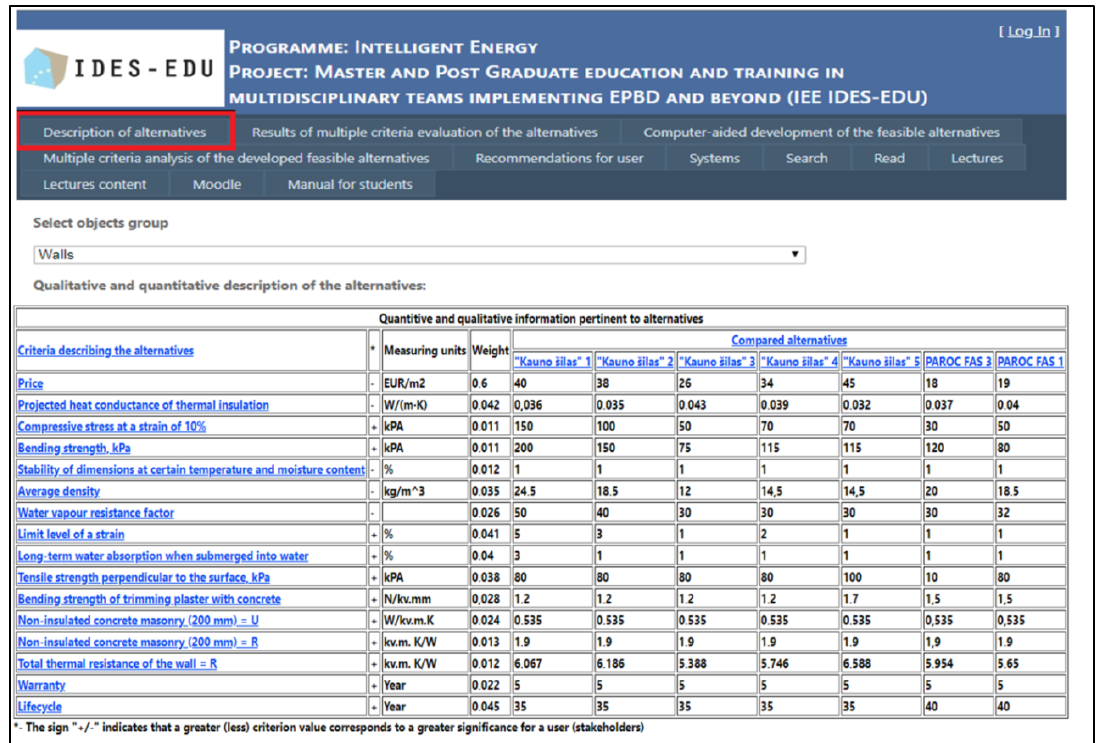
Figure 3. Initial data for analysis of the insulation of walls.